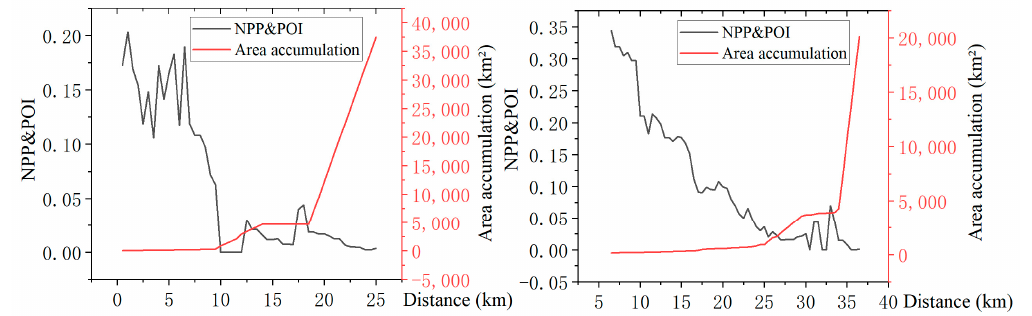
Figure 4. Variation of NPP and POI and its isosurface area with distance (take 30 and 121 transects as an example).